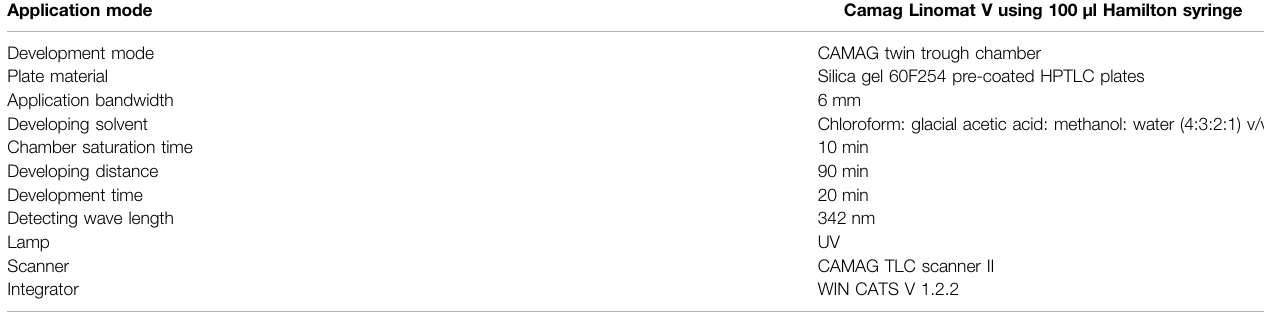
TABLE 2 | HPTLC conditions. Application mode